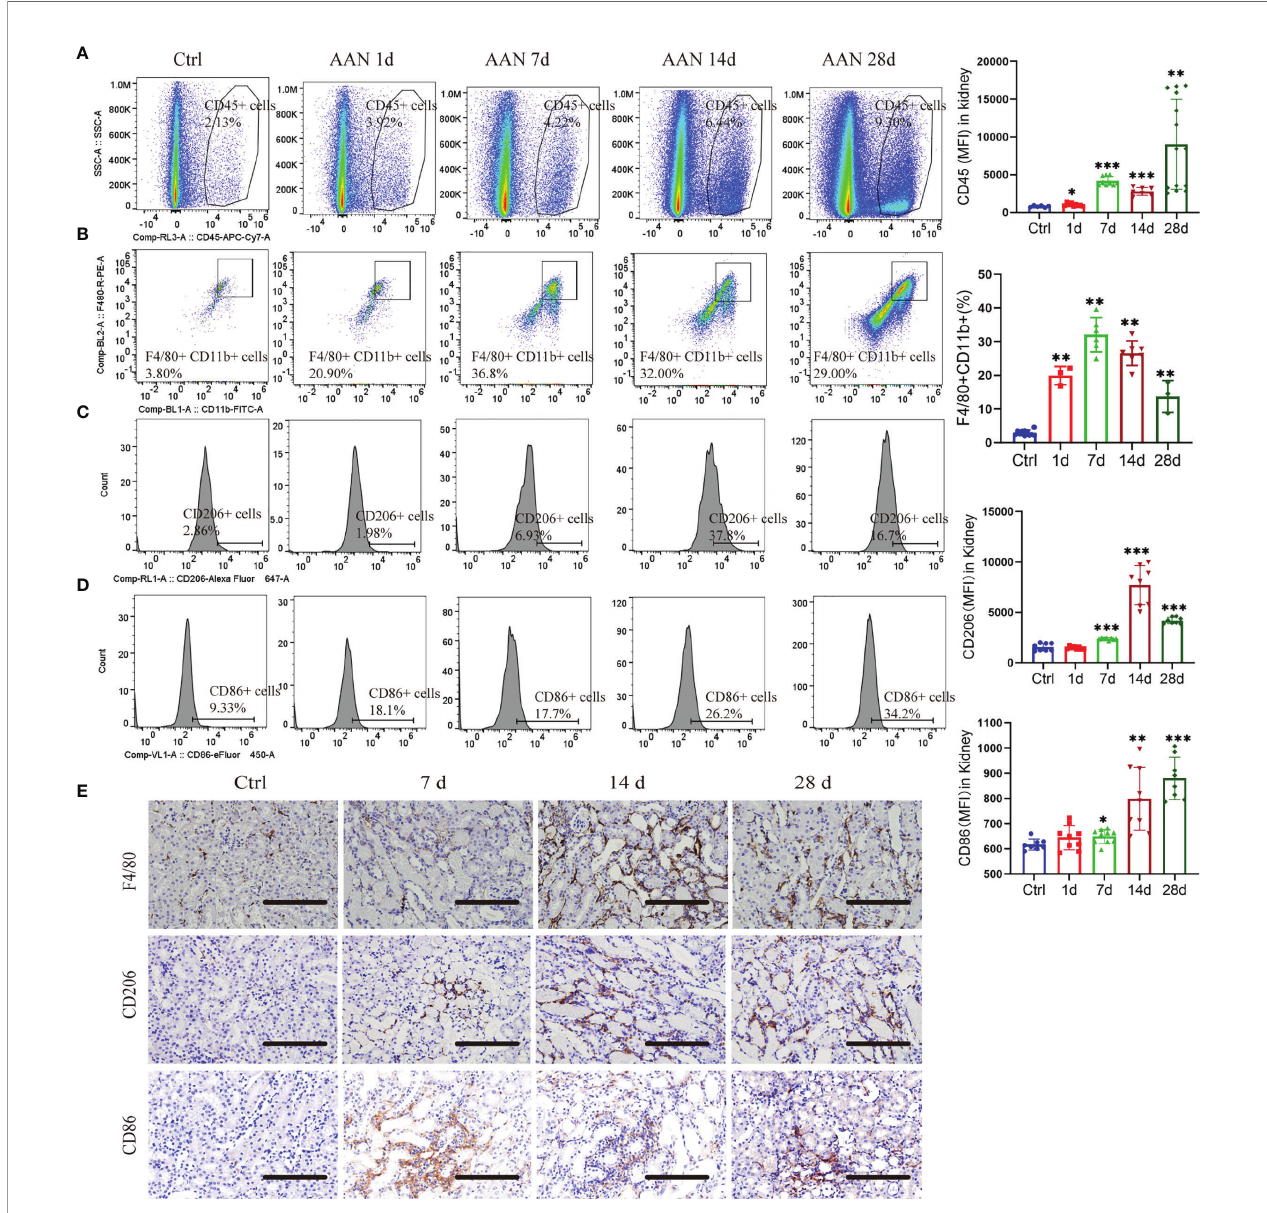
FIGURE 1 | Macrophages undergo polarization during AA nephropathy. (A) Representative fl ow cytometry plots and mean fl uorescence intensity (MFI) of CD45+ leukocytes in renal in control and 1, 3, 7, 14, and 28 days of AAN. (B) Representative fl ow cytometry plots and percentage of CD11b+F4/80+ macrophages in kidney in control and 1, 3, 7, 14, and 28 days of AAN. (C) Representative fl ow cytometry images and MFI of CD206+ macrophages in control and 1, 3, 7, 14, and 28 days of AAN. (D) Representative fl ow cytometry images and MFI of CD86+ macrophages in control and 1, 3, 7, 14, and 28 days of AAN. (E) Representative images of immunostaining for F4/80 and CD206 in renal sections in control and 7, 14, and 28 days of AAN. Scale bars, 200 m m. n = 6 mice each group. * P < 0.05; ** P < 0.01; *** P < 0.001